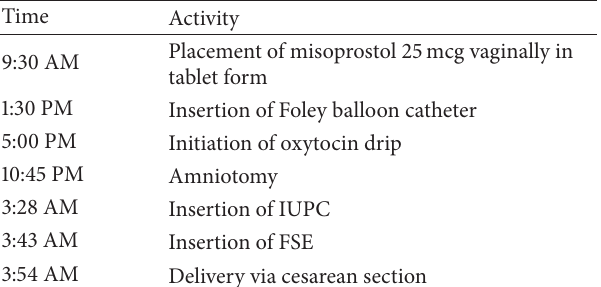
Table 1: Sequence of